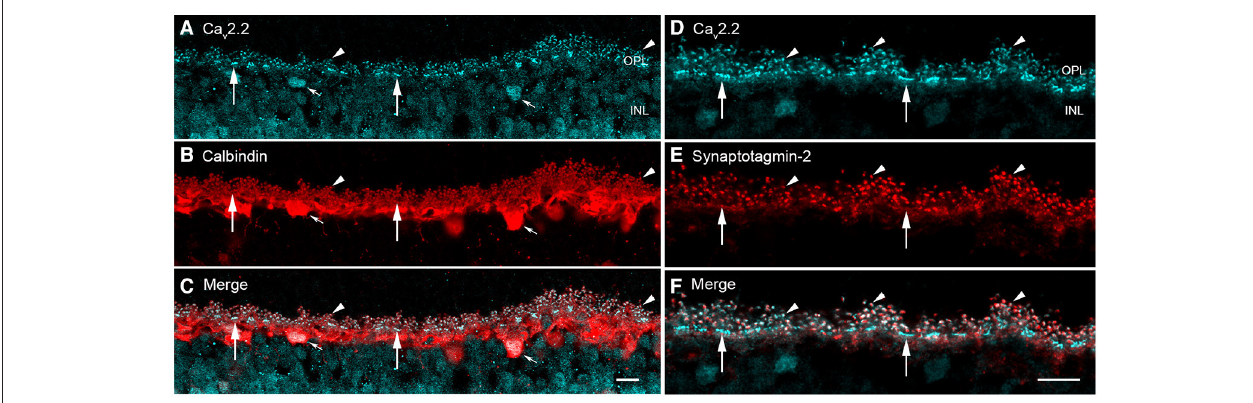
FIGURE 10 | Voltage-gated calcium channels and calcium sensor synaptotagmin-2 are expressed in mouse horizontal cell endings. (A–C) Ca v 2.2 ( α 1B, N-type) Ca channels immunolabeling ( A , blue) occurred as discrete puncta in the OPL in mouse retina (arrowheads). (B) Calbindin immunolabeling (red) identifies horizontal cells in outer retina (arrowheads). (C) Merged image showed co-localization of Ca v 2.2 and calbindin immunoreactivities (arrowheads), suggesting Ca v 2.2 is at horizontal cell synaptic endings. Small arrows point to Ca v 2.2 immunoreactivity in horizontal cell bodies, suggesting that Ca v 2.2 is expressed by horizontal cells and not photoreceptors. (D–F) Ca v 2.2 co-localizes with the calcium sensor synaptotagmin-2 in horizontal cells. (D) Ca v 2.2 (blue) immunolabeling occurred as puncta (arrowheads) and bars (arrows) in the OPL. (E) Calcium sensor synaptotagmin-2 (red) immunolabeling occurred in horizontal cell processes and is concentrated in the tips. (F) Merged image showed that Ca v 2.2 and synaptotagmin-2 are present in the same subcellular compartment of the horizontal cell axonal endings. The synaptotagmin-2 immunostaining in horizontal cell dendrites at cones (arrows) appeared to be less intense than at the axonal endings, perhaps simply reflecting the